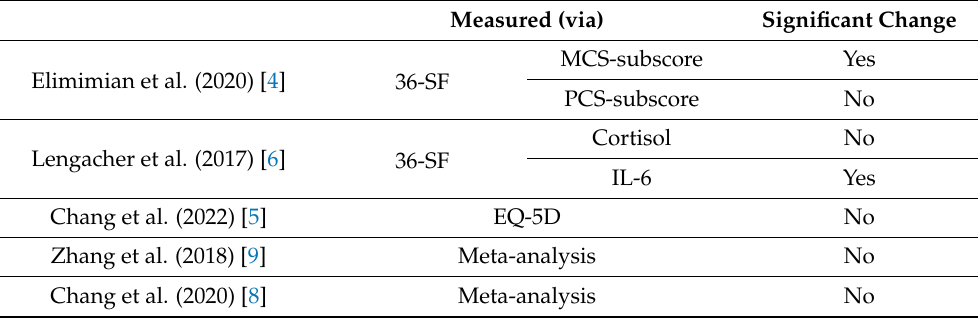
Table 10. Primary Outcome (Quality of Life) Results